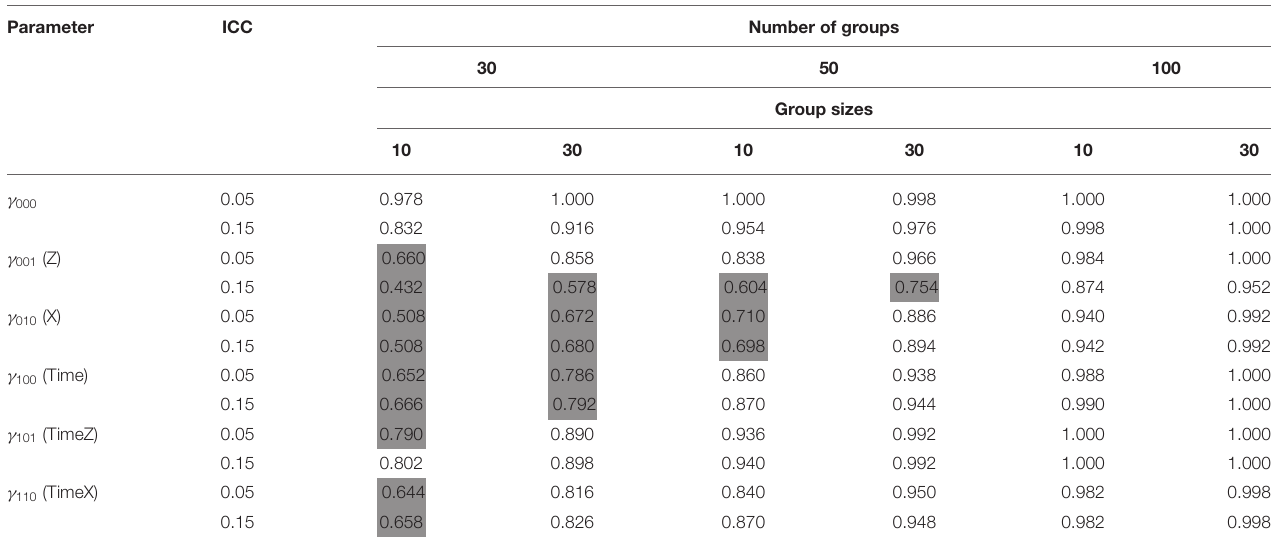
TABLE 4 | Power for fixed